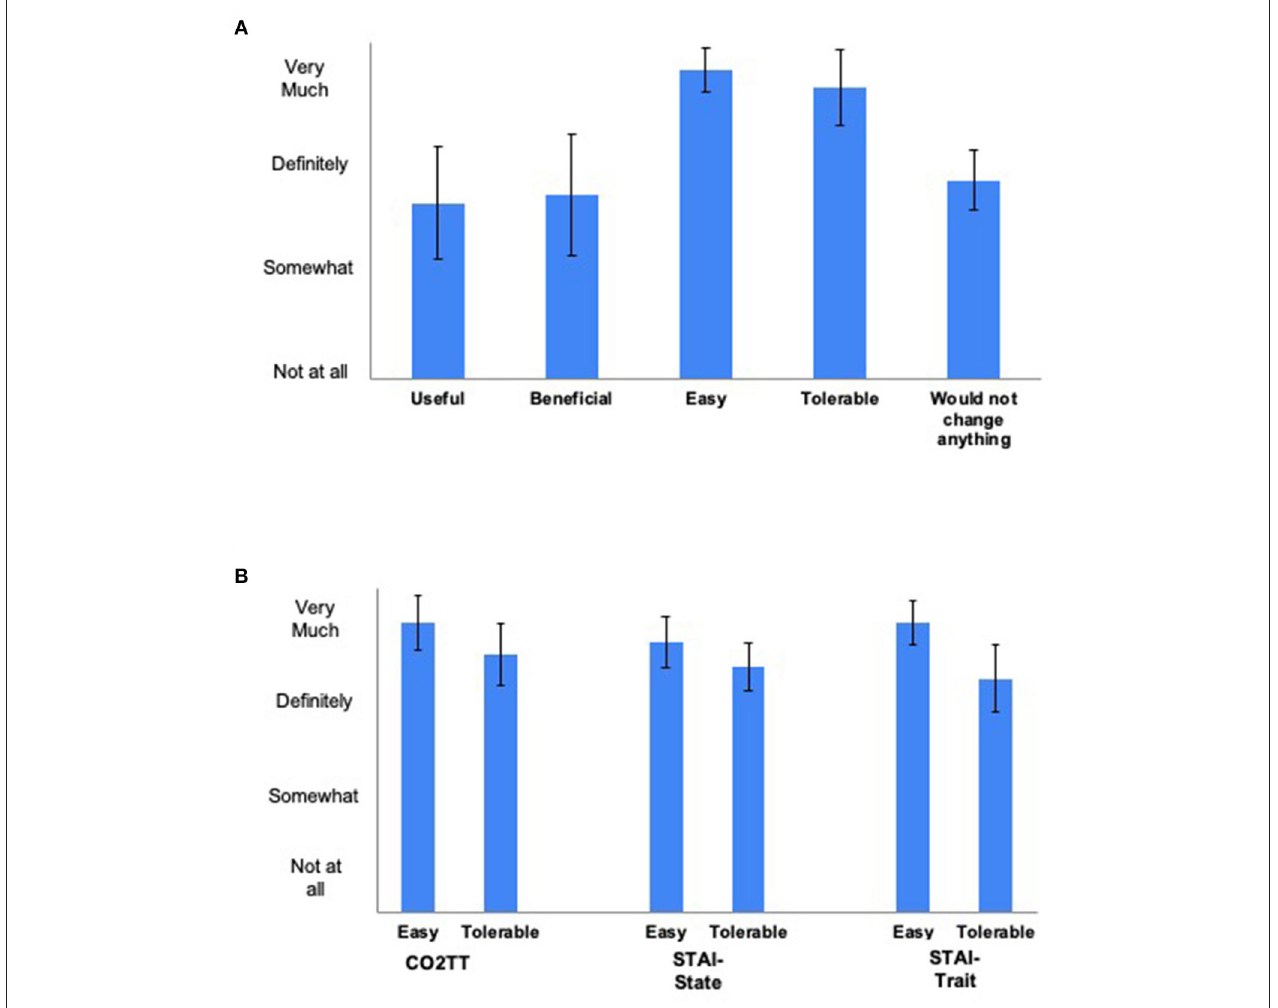
FIGURE 3 | (A) Mean (95% confidence intervals) student ratings of the breathing curriculum ( n = 13 student respondents). (B) Mean (95% confidence intervals) student ratings of the study assessments (n = 17 student respondents). CO 2 TT, carbon dioxide tolerance test; STAI, State-Trait Anxiety